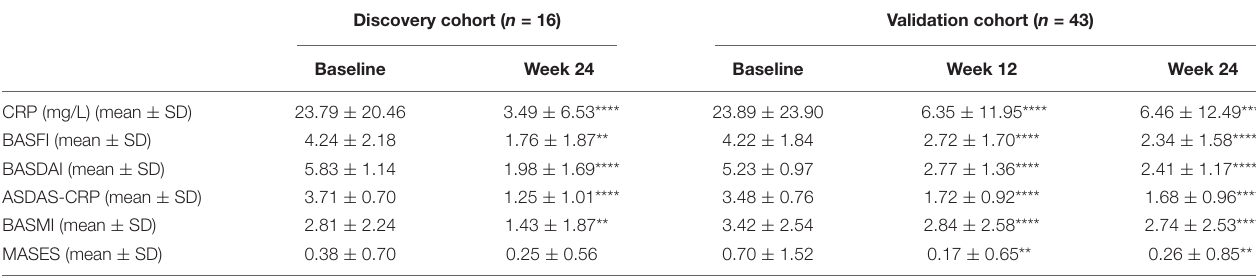
TABLE 2 | Clinical features of the AS patients treated with